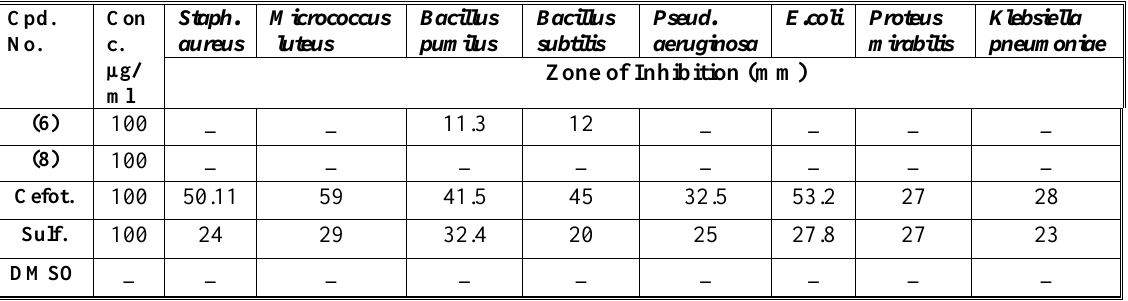
Table 2. Antifungal activity of the tested compounds. Compound